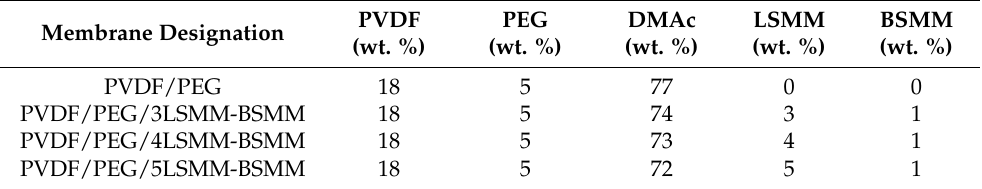
Table 1. Composition of dope solution hollow fiber membranes.